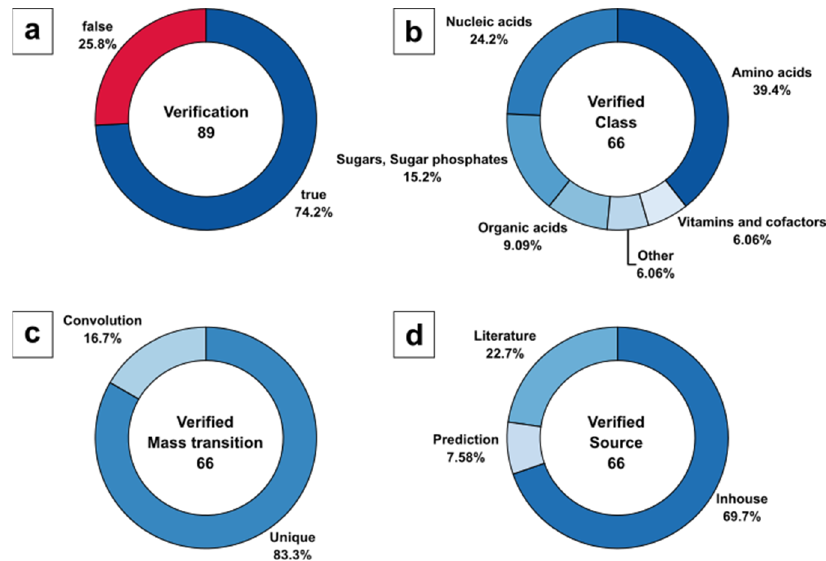
Figure 5. Evaluation of DS-FIA-MS/MS by metabolite verification of the PPA metabolome standard: ( a ) Identified metabolites based on certificate of analysis (routinely identified metabolites) with annotation in KEGG; ( b ) Analyte classification of verified and identified metabolites based on certificate of analysis; ( c ) Classification of verified and identified metabolites based on unique and convoluted mass transitions; ( d ) Classification of verified and identified metabolites based on mass transition